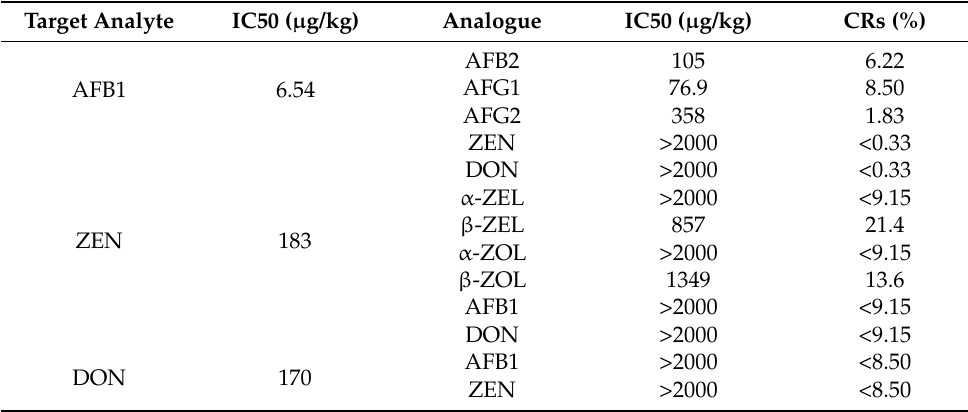
Table 2. Cross-reactivity between AFB1, ZEN, DON and their analogues.